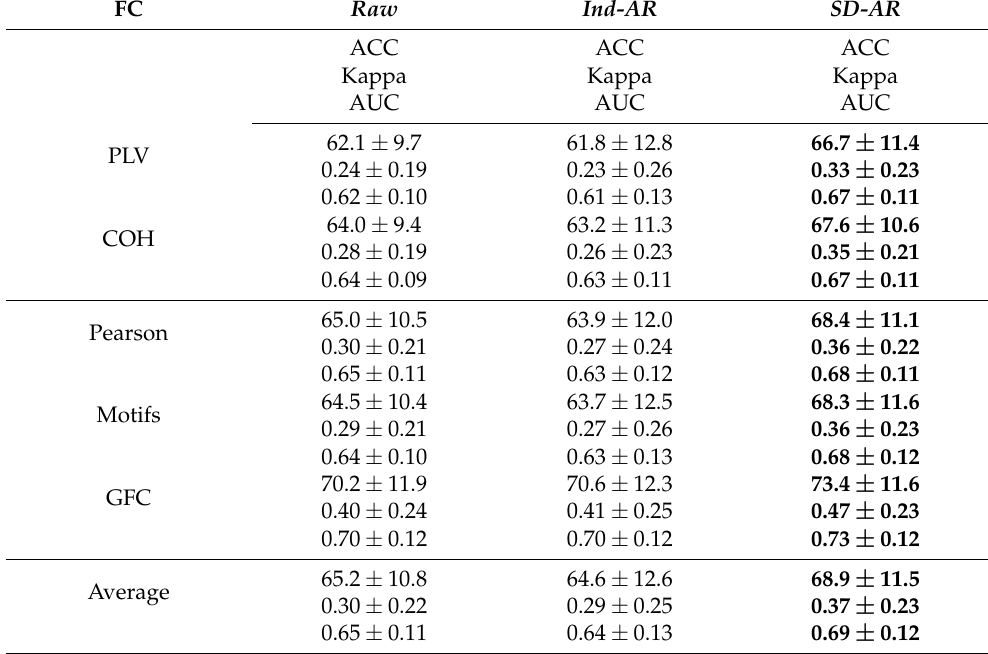
Table 2. The performance of each FC measure in DBII for each of the training classifier scenarios considered. The last row shows the performance values averaged over the whole subject set and across the evaluated FC measures. FC: Functional connectivity. Bold stands for the best results. FC Raw Ind-AR SD-AR ACC ACC ACC Kappa Kappa Kappa AUC AUC AUC 62.1 ± PLV